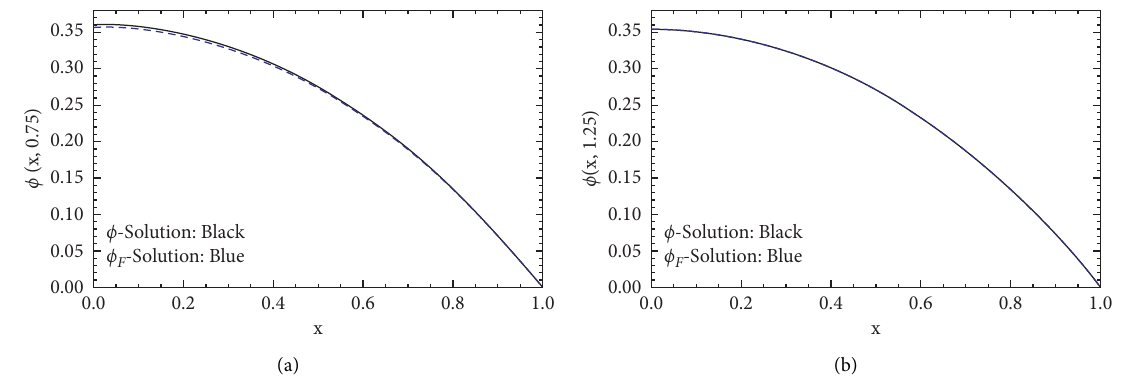
Figure 2: The approximate and exact solutions at F � 7 via T